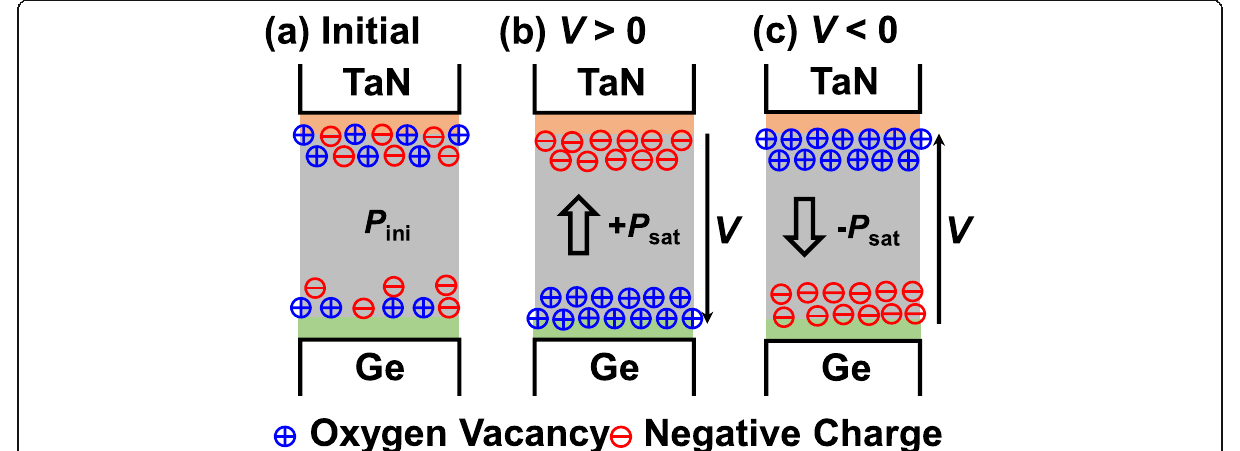
Fig. 3 Schematics of the mechanism for ferroelectric-like behavior in Al 2 O 3 capacitors. Switchable P is due to the migration of oxygen vacancies and negative charges to form dipoles